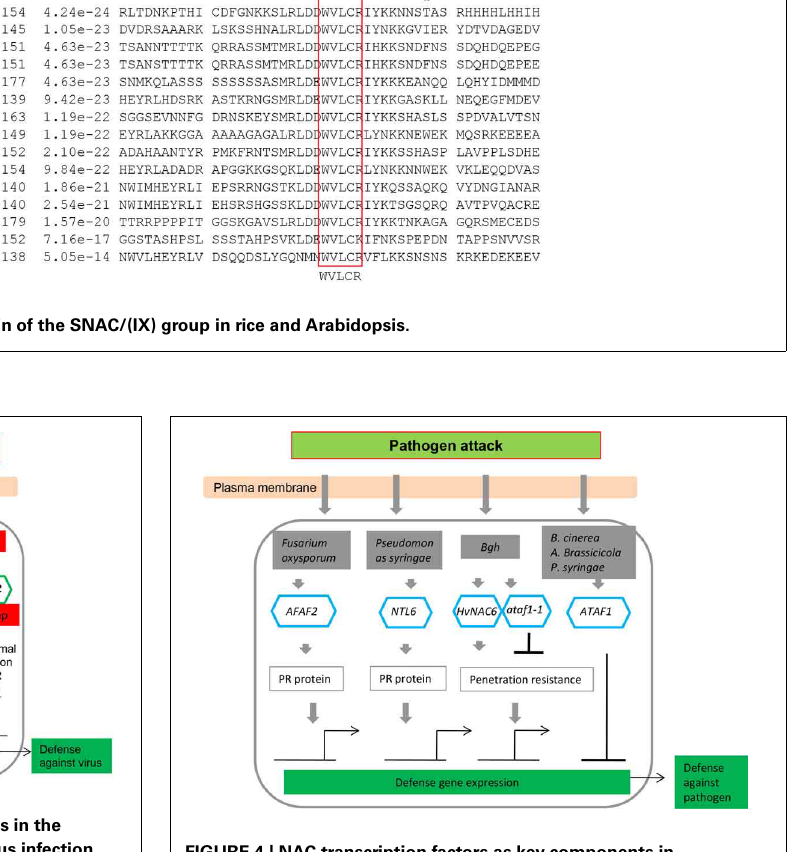
FIGURE 4 | NAC transcription factors as key components in transcriptional regulation of gene expression during pathogen attack, integrating both positive (arrows) and negative (bars) regulatory